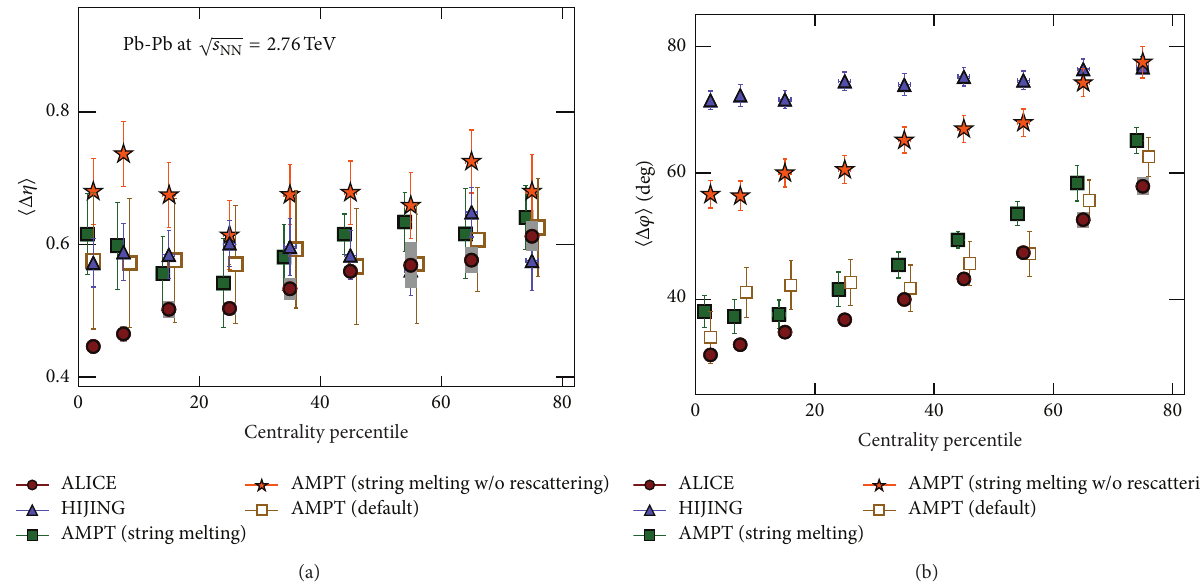
Figure 20: The centrality dependence of the widths of BF ⟨Δ𝜂⟩ and ⟨Δ𝜙⟩ , for the correlations studied in terms of the relative pseudorapidity and the relative azimuthal angle, respectively. The data points are compared to the predictions from HIJING [42, 43] and AMPT [44]. The graph is taken from [37].